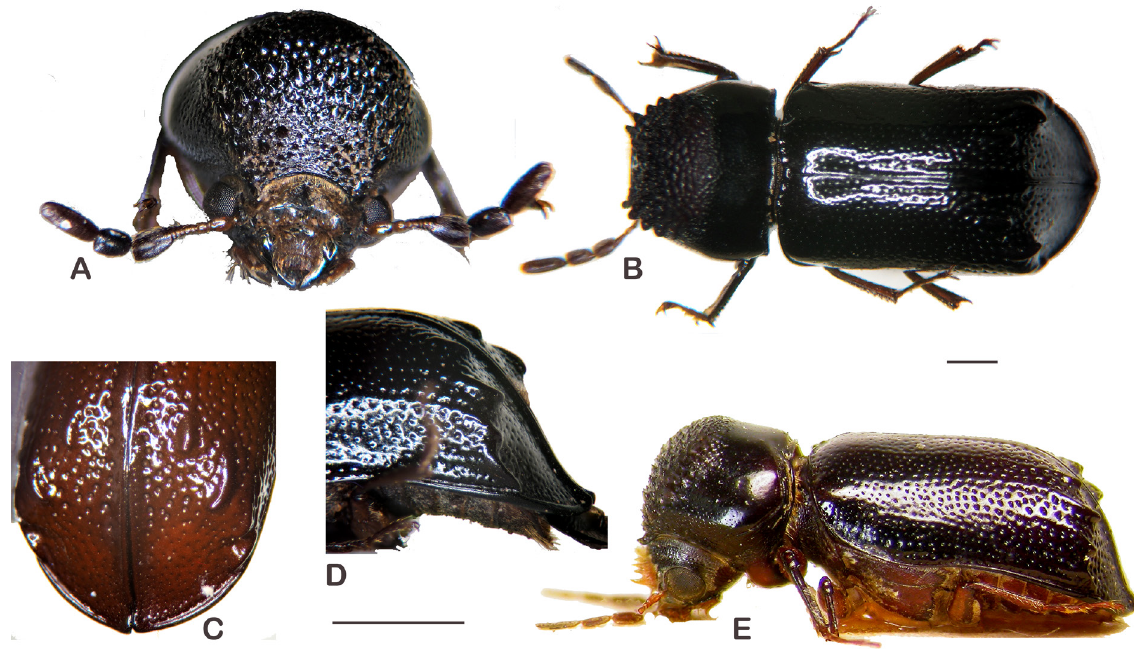
Fig 3. Xylothrips religiosus (Boisduval, 1835), ♀ (LYL). A . Frontal view. B . Dorsal view. C . Declivity. D . Lateral view of declivity. E . Lateral view. Scale bars = 1 mm (upper scale for B, E; lower scale for A,